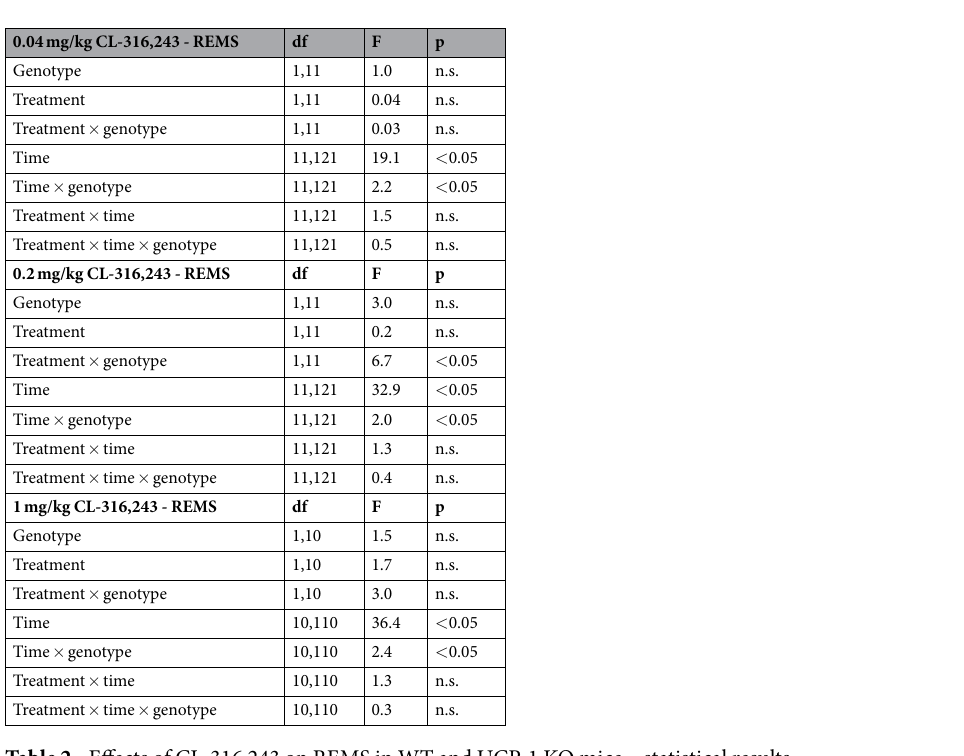
Table 2. Effects of CL-316,243 on REMS in WT and UCP-1 KO mice – statistical